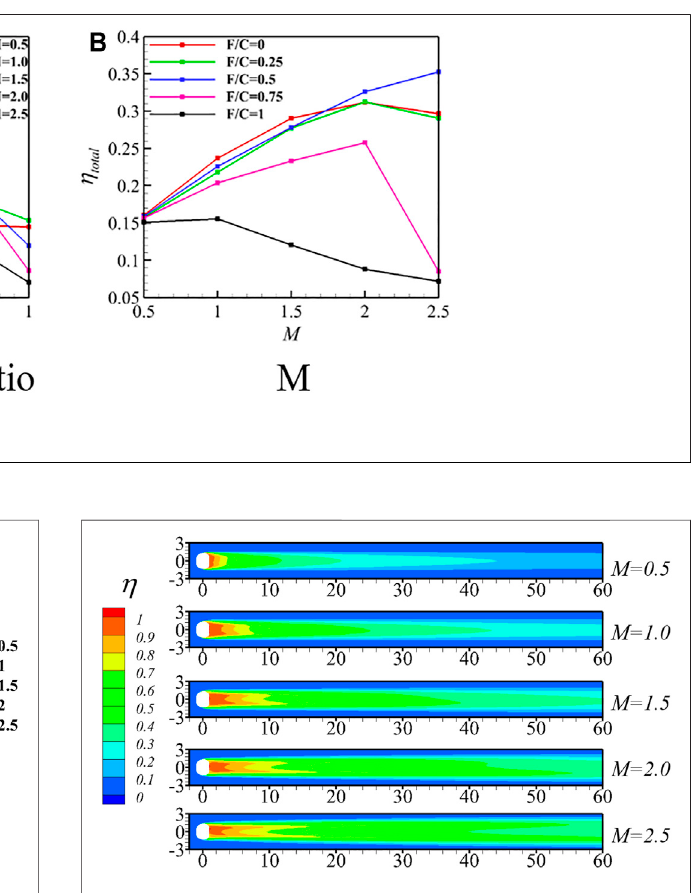
FIGURE 5 | Adiabatic cooling effectiveness contour in C/L (cid:2) 0.5